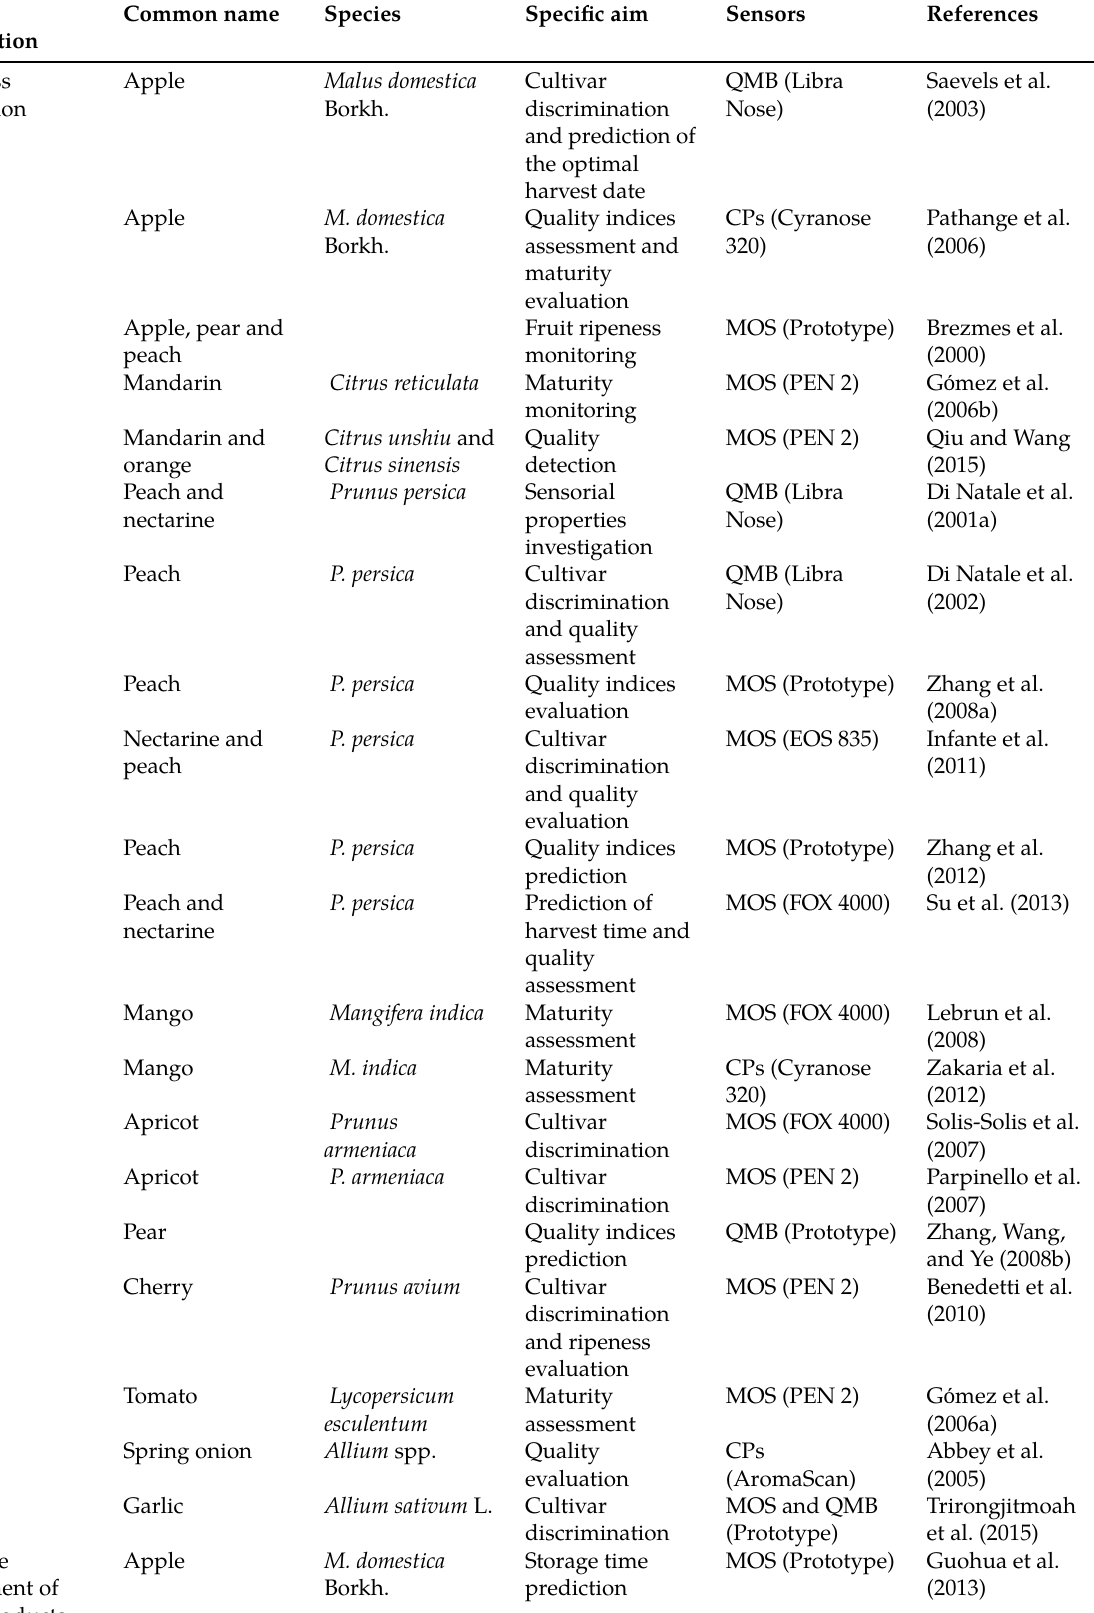
Table 2: Overview of applications of electronic nose on fruit and vegetables.